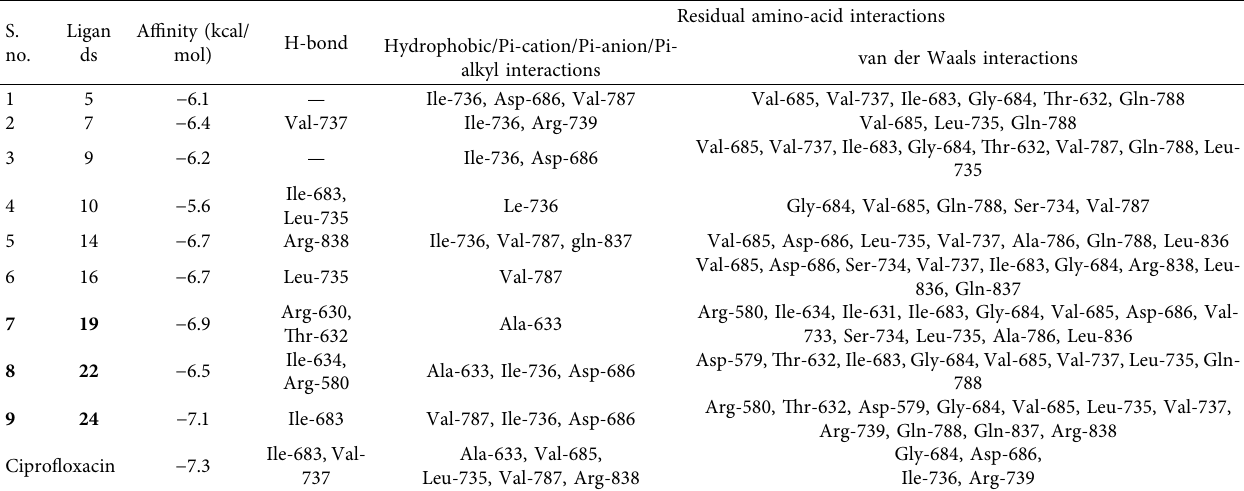
Table 11: Molecular docking results of synthesized compounds against E.coli DNA gyrase A (PDB ID